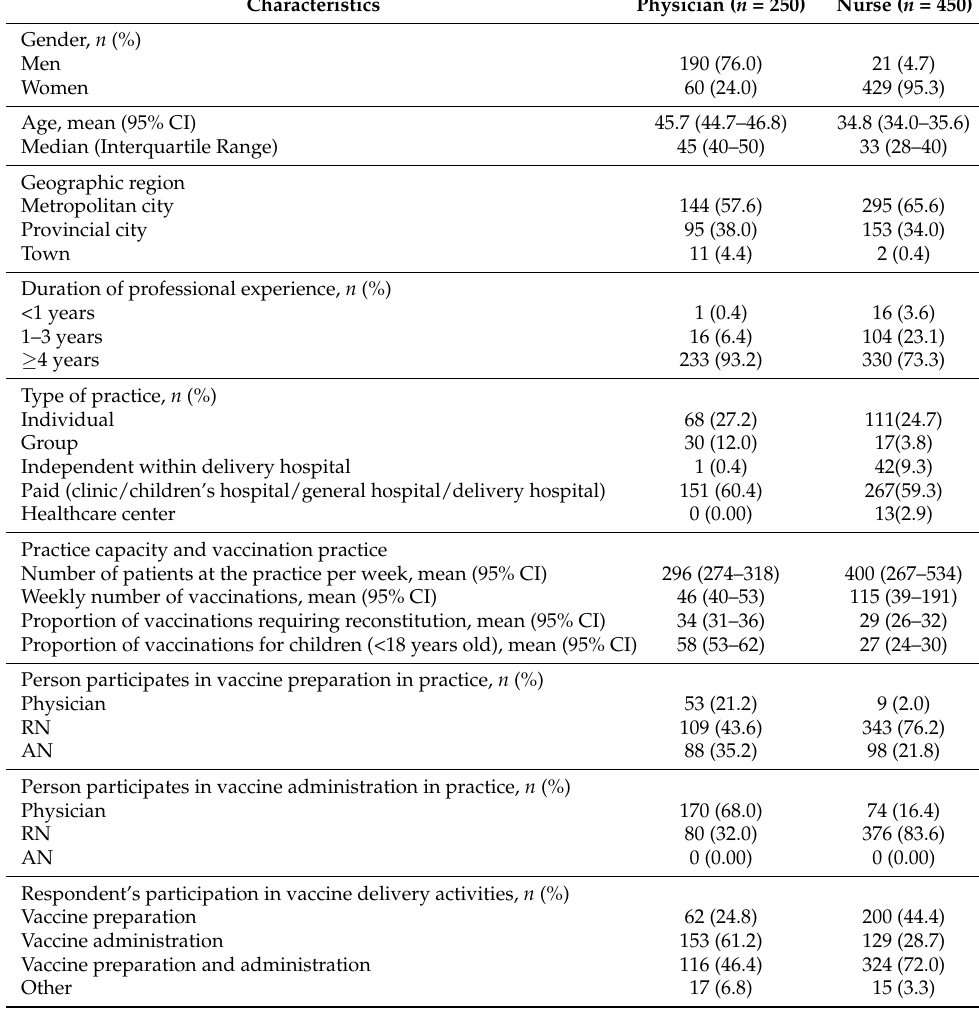
Table 1. Sociodemographic and current clinical practice profile of participants by